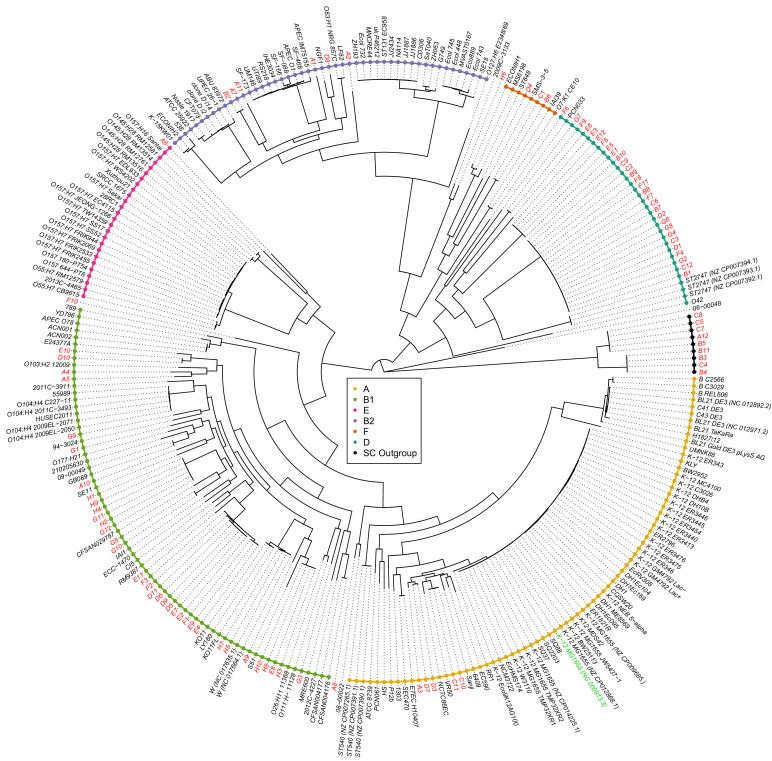
Joint maximum likelihood phylogeny of our strains and 189 E.coli reference strains.Maximum likelihood tree reconstructed from the core genome alignments of the SC1 strains (red font names), the K-12 lab strain (green font name), and 189 E. coli reference strains (black font names). Known phylogroups are indicated as different colored leaf nodes. The SC1 strains are distributed across essentially all known phylogroups, include strains that cannot be easily assigned to a phylogroup, and a distal ‘outgroup’ of nine strains (black leaves) that are at 6% nucleotide divergence from other strains (branch shortened).